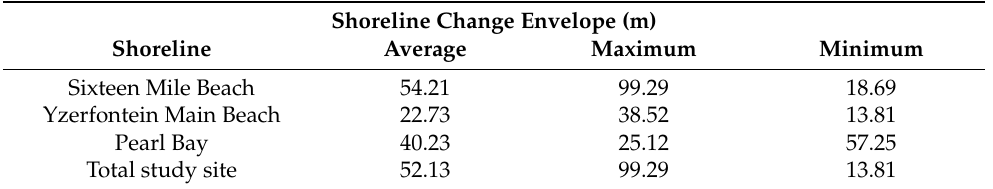
Table 6. Summary of Shoreline Change Envelope (SCE) along the study site shoreline and its three beaches irrespective of the direction of movement.